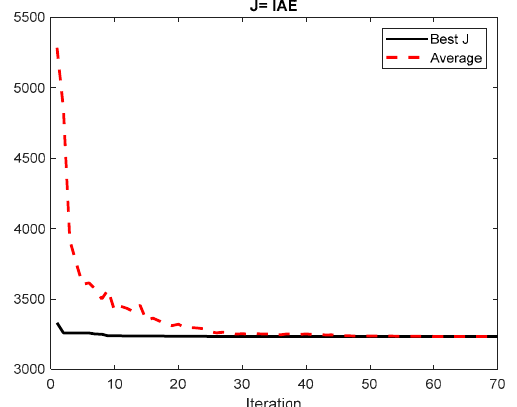
Figure 11. PSO evolution of the best IAE value and average swarm IAE values corresponding to the test in Figures 9 and 10.